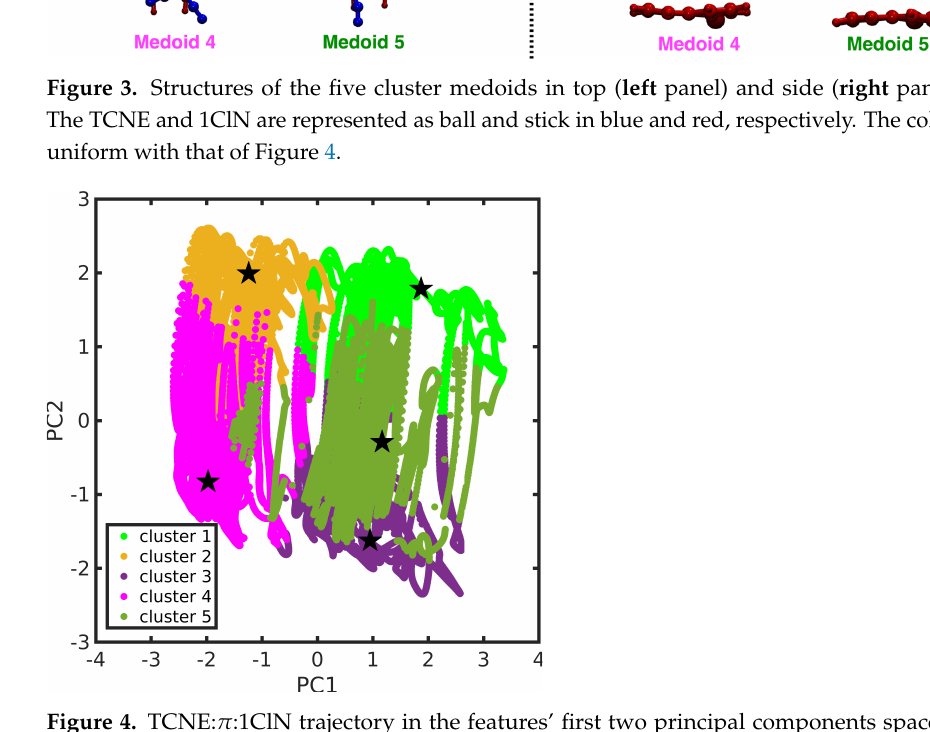
Figure 4. TCNE: π :1ClN trajectory in the features’ first two principal components space. Cluster partition is represented through different colors. Cluster medoids are also highlighted (as star symbols). The color scheme adopted is kept fixed throughout this